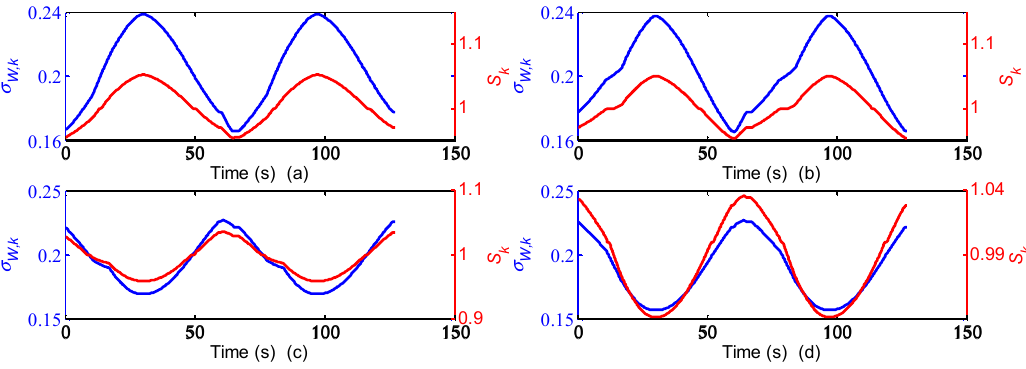
Figure 18. Input and output result of FIS, ( a ) first anchor node; ( b ) second anchor node; ( c ) third anchor node; ( d ) fourth anchor node. Table 1. Performance comparison for different integration models.